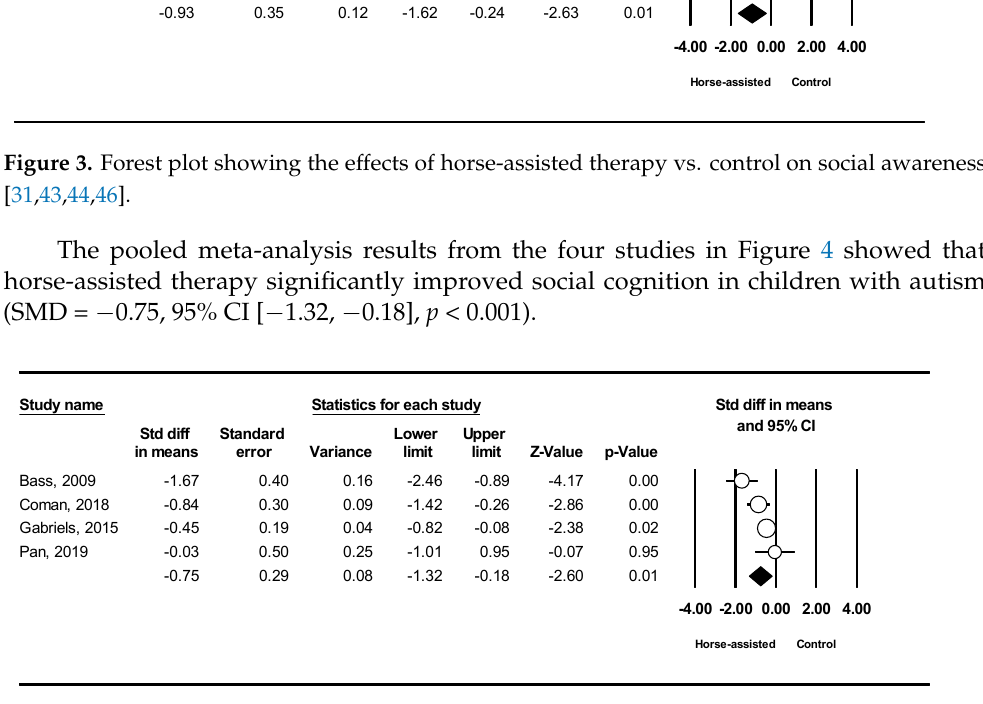
Figure 4. Forest plot showing the effects of horse-assisted therapy vs. control on social cognition [31,43,44,46].